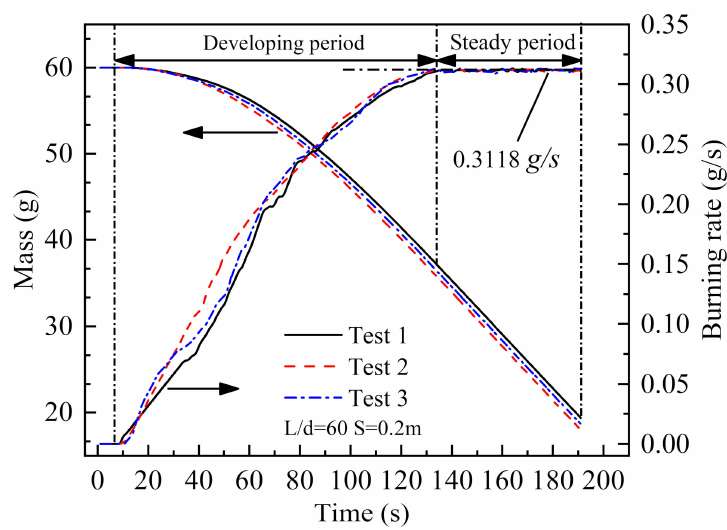
Figure 2. Instantaneous burning of line fires with L / d = 60 and S = 0.2 m.